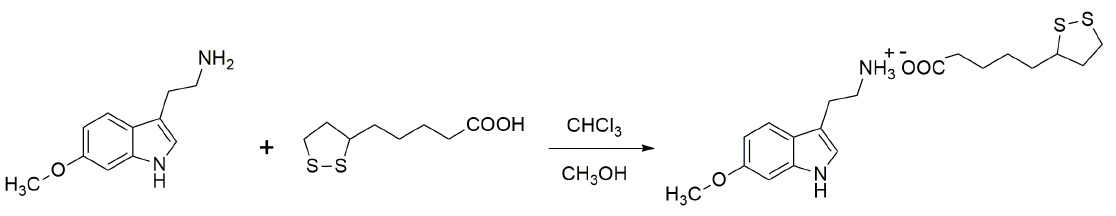
Figure 1. Synthesis and structure of 5-methoxytryptamine- α -lipoic acid (MLA).